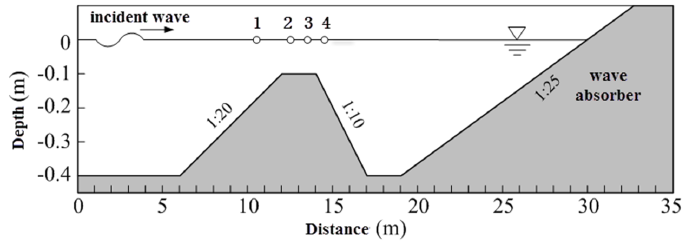
Figure 9. Sketch of the experimental setup of Beji.